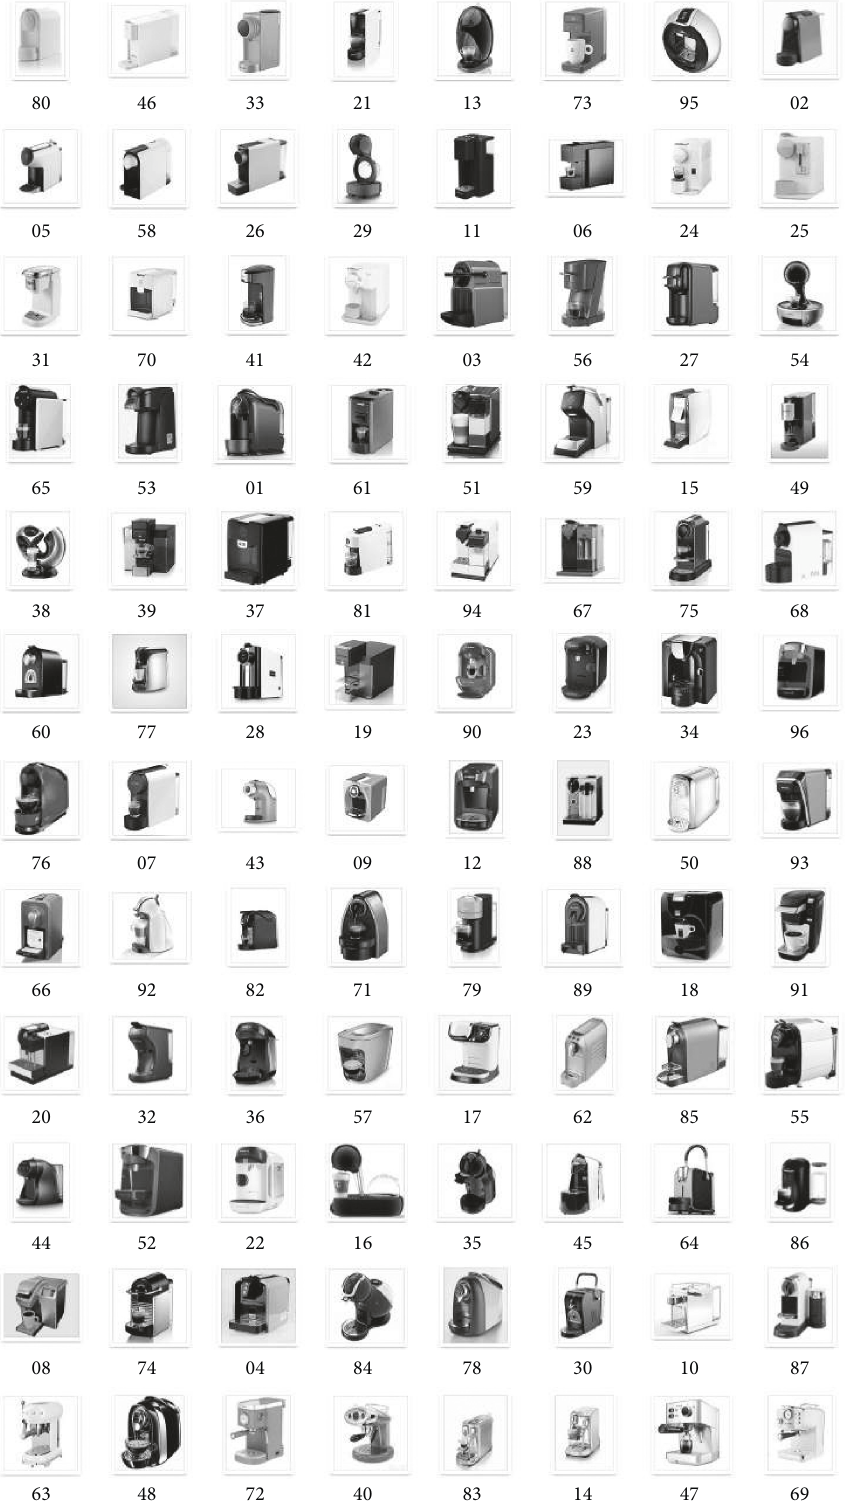
Figure 11: Samples list in order of